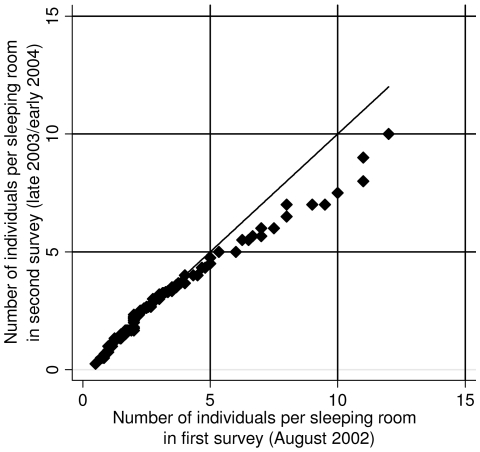
Quantile-quantile plot of the number of individuals per sleeping room in the two surveys carried out in August 2002 and late 2003/early 2004 in the region of Man, western Côte d'Ivoire.